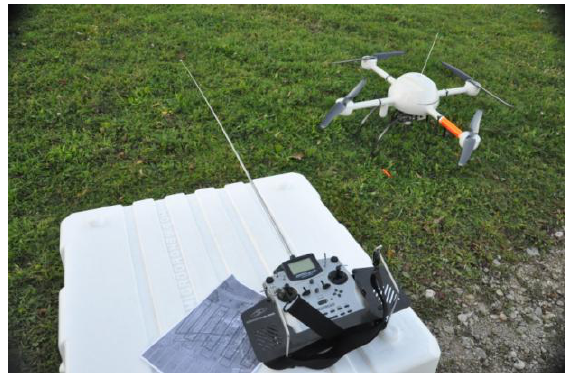
Figure 2. Microcopter md4-1000 with remote control The images have been taken by the Olympus PEN E-P2, and lens with 17.0 mm focal length. The sensor has 12.3 megapixels of the resolution.